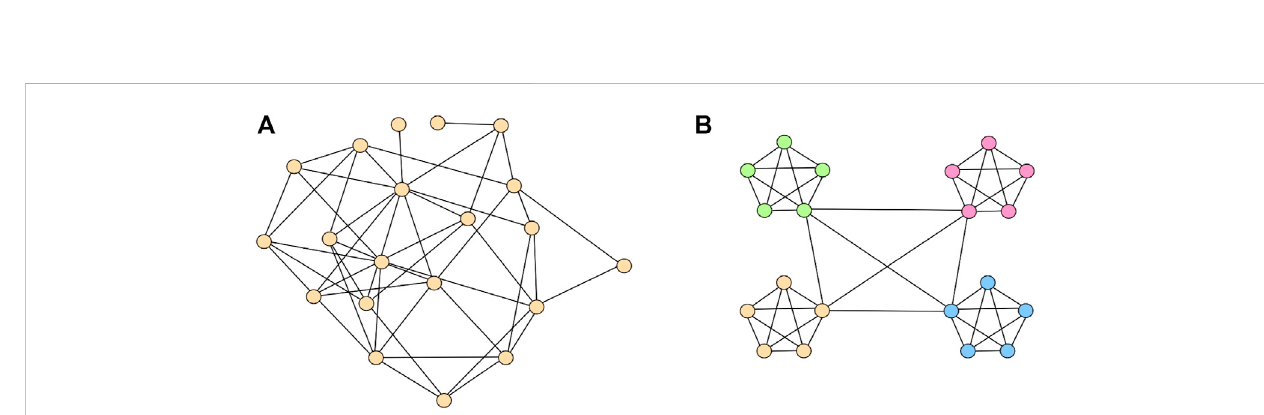
FIGURE 7 Community structure and the network modularity indicator Q [61]. (A) Random network with N = 20 nodes and L = 46 links. The random network does not present a community structure, and it returns a modularity indicator value of Q (cid:2) 0 . 24. (B) A network of N = 20 nodes and L = 46 links with a strong community structure (node color distinguishes nodes belonging to the same community); this network is composed of four clearly separated communities, and Q (cid:2) 0 .